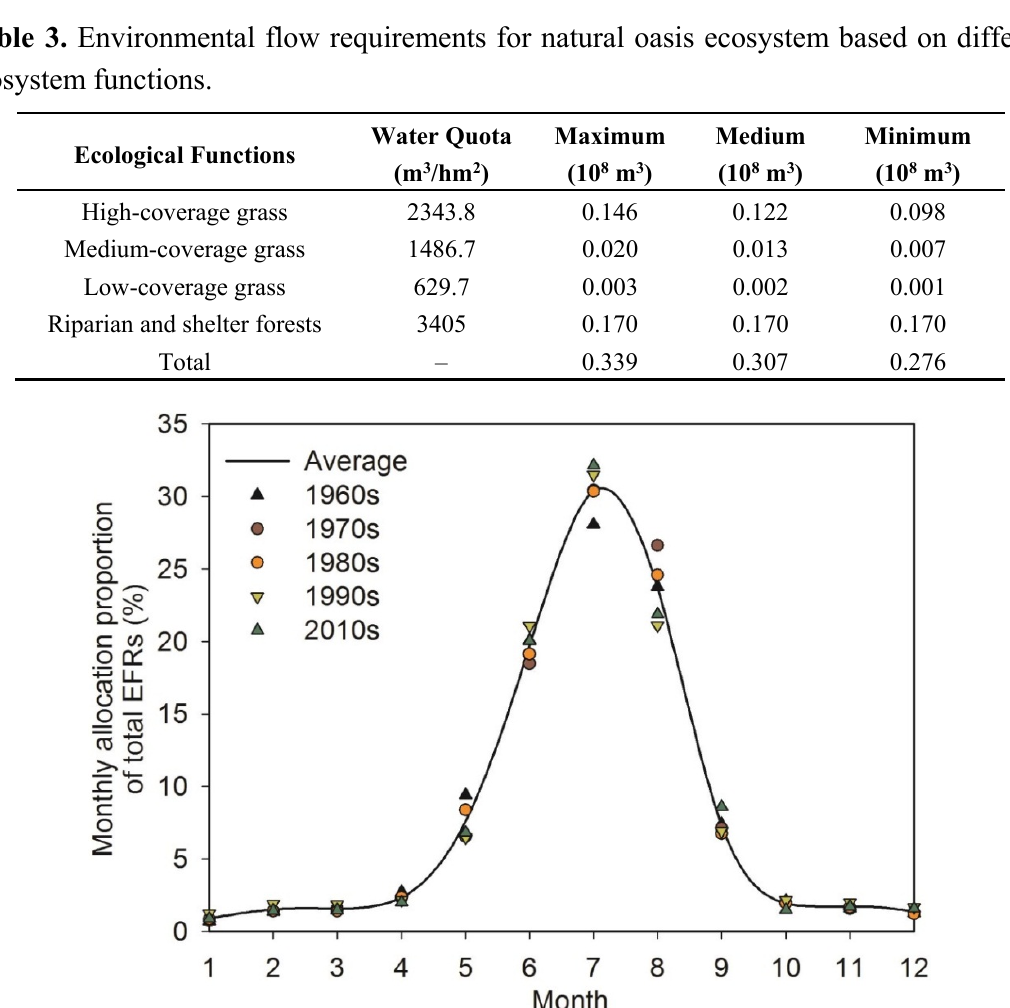
Figure 4. Proportion of temporal allocation for the total EFRs during different periods in Qira